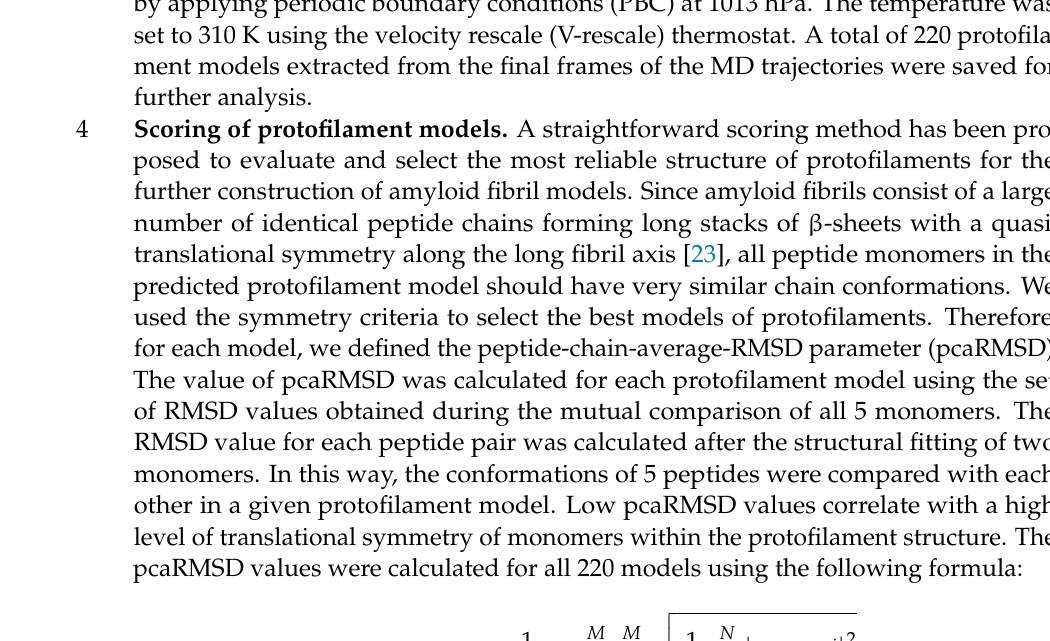
Construction of the amyloid fibril model using protofilament structures . The amy- loid fibril model was constructed using the top-scored protofilament structures as building blocks. The fibril assembly procedure included a series of translations. First, two copies of single protofilament models were superimposed using structural alignment based on only four monomer chains in each protofilament model. More specifically, peptide chains from the second to the fifth (monomers 2–5) of the start- ing protofilament model (Figure 1, protofilament shown in red color) were used for structural fitting of the next identical protofilament model (Figure 1, protofilament shown in blue color), using peptide chains from the first to the fourth (monomers 1–4). During the structural fitting, the coordinates of the starting protofilament model